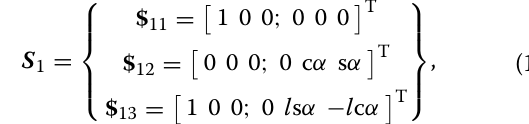
The constraint screw system in Eq. (7) indicates that there are two constraint forces delivered on the platform. One of them passes through the center of the upper rA joint, whose direction is consistent with the outer axis of the lower rA joint. Another constraint force passes through the center of the lower rA joint, and the direc- tion is consistent with the twist S 14.